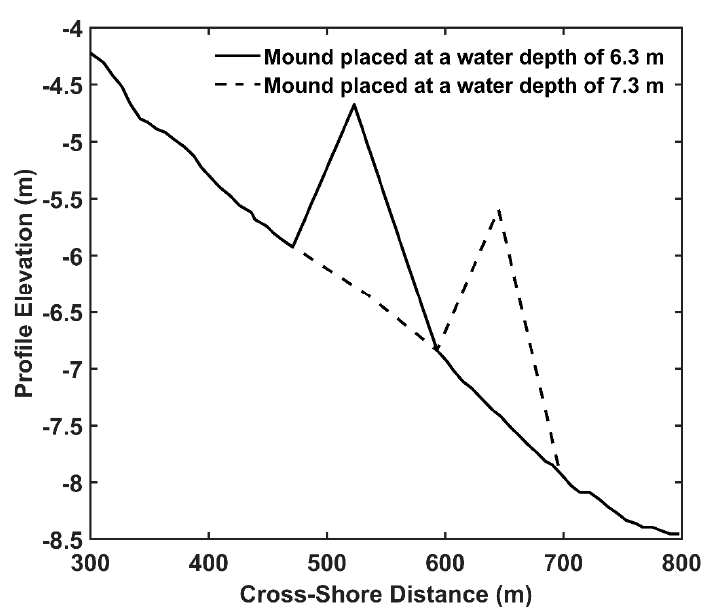
Figure 11. Studied schematized triangular mounds placed at di ff erent water depths, but having the same initial volume.